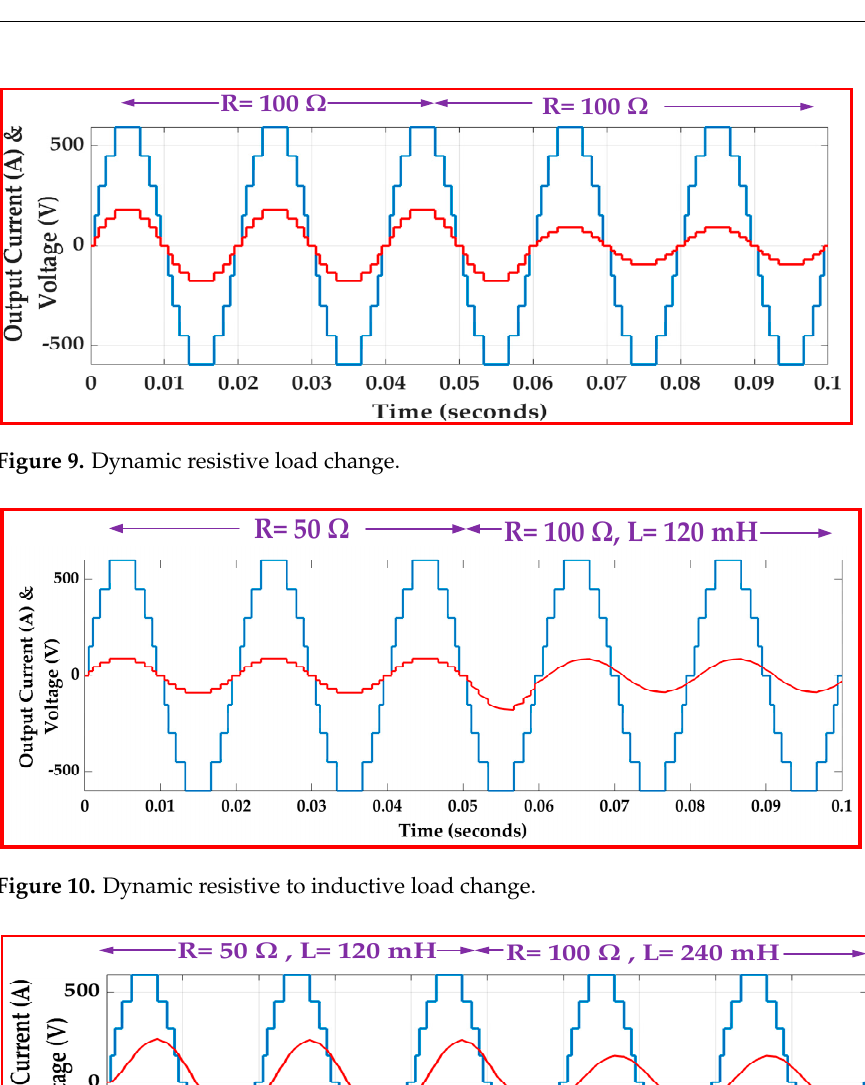
Figure 8. Harmonic profile and outputs of PEC-9.